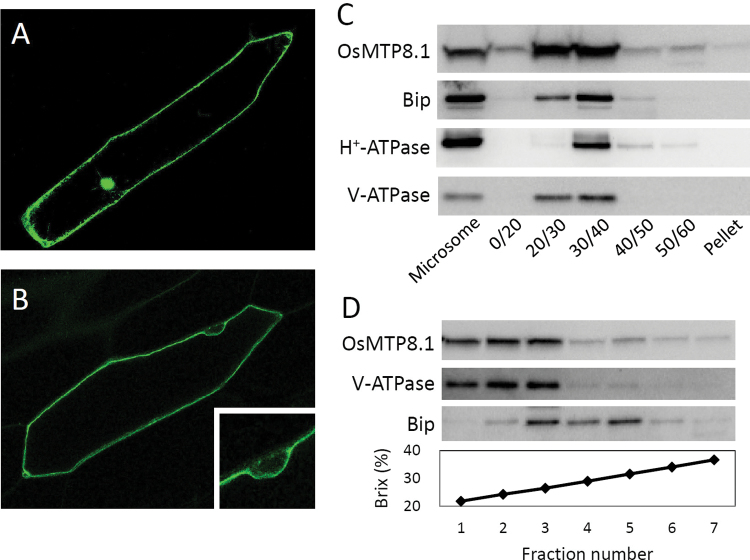
Subcellular localization of OsMTP8.1. (A, B) Localization of GFP (A) and the OsMTP8.1:GFP fusion protein (B) transiently expressed in onion epidermal cells. A magnified view of the image surrounding the nucleus is shown in (B). Expression was monitored 12h after transformation. Scale bars=100 µm. (C) Western blot analysis of OsMTP8.1 in shoot membrane fractions prepared using a discontinuous sucrose density gradient. Antibodies to marker proteins of the ER (anti-Bip), plasma membrane (anti-H+-ATPase), and tonoplast (anti-V-ATPase) were used to probe the blots. (D) Western blot analysis of OsMTP8.1 in microsome fractions prepared in the presence of Mg2+. Brix=1g of sucrose in 100g of solution.